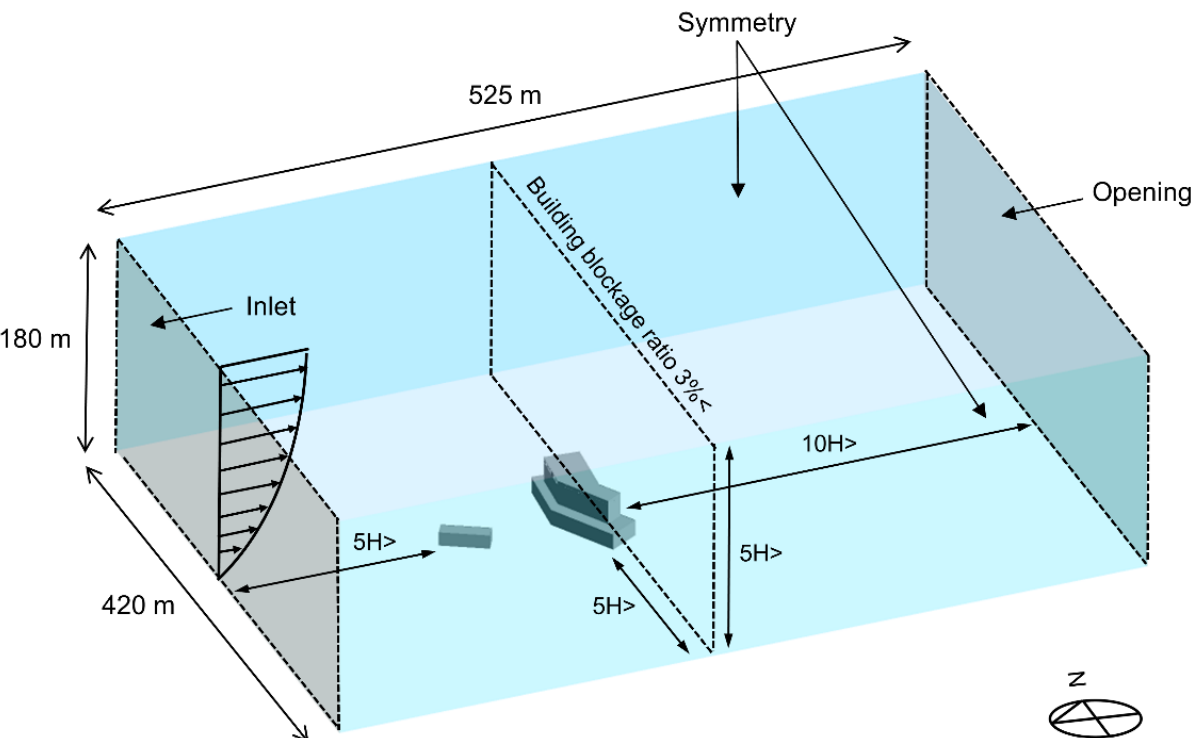
Figure 1. Domain for outdoor CFD simulation.